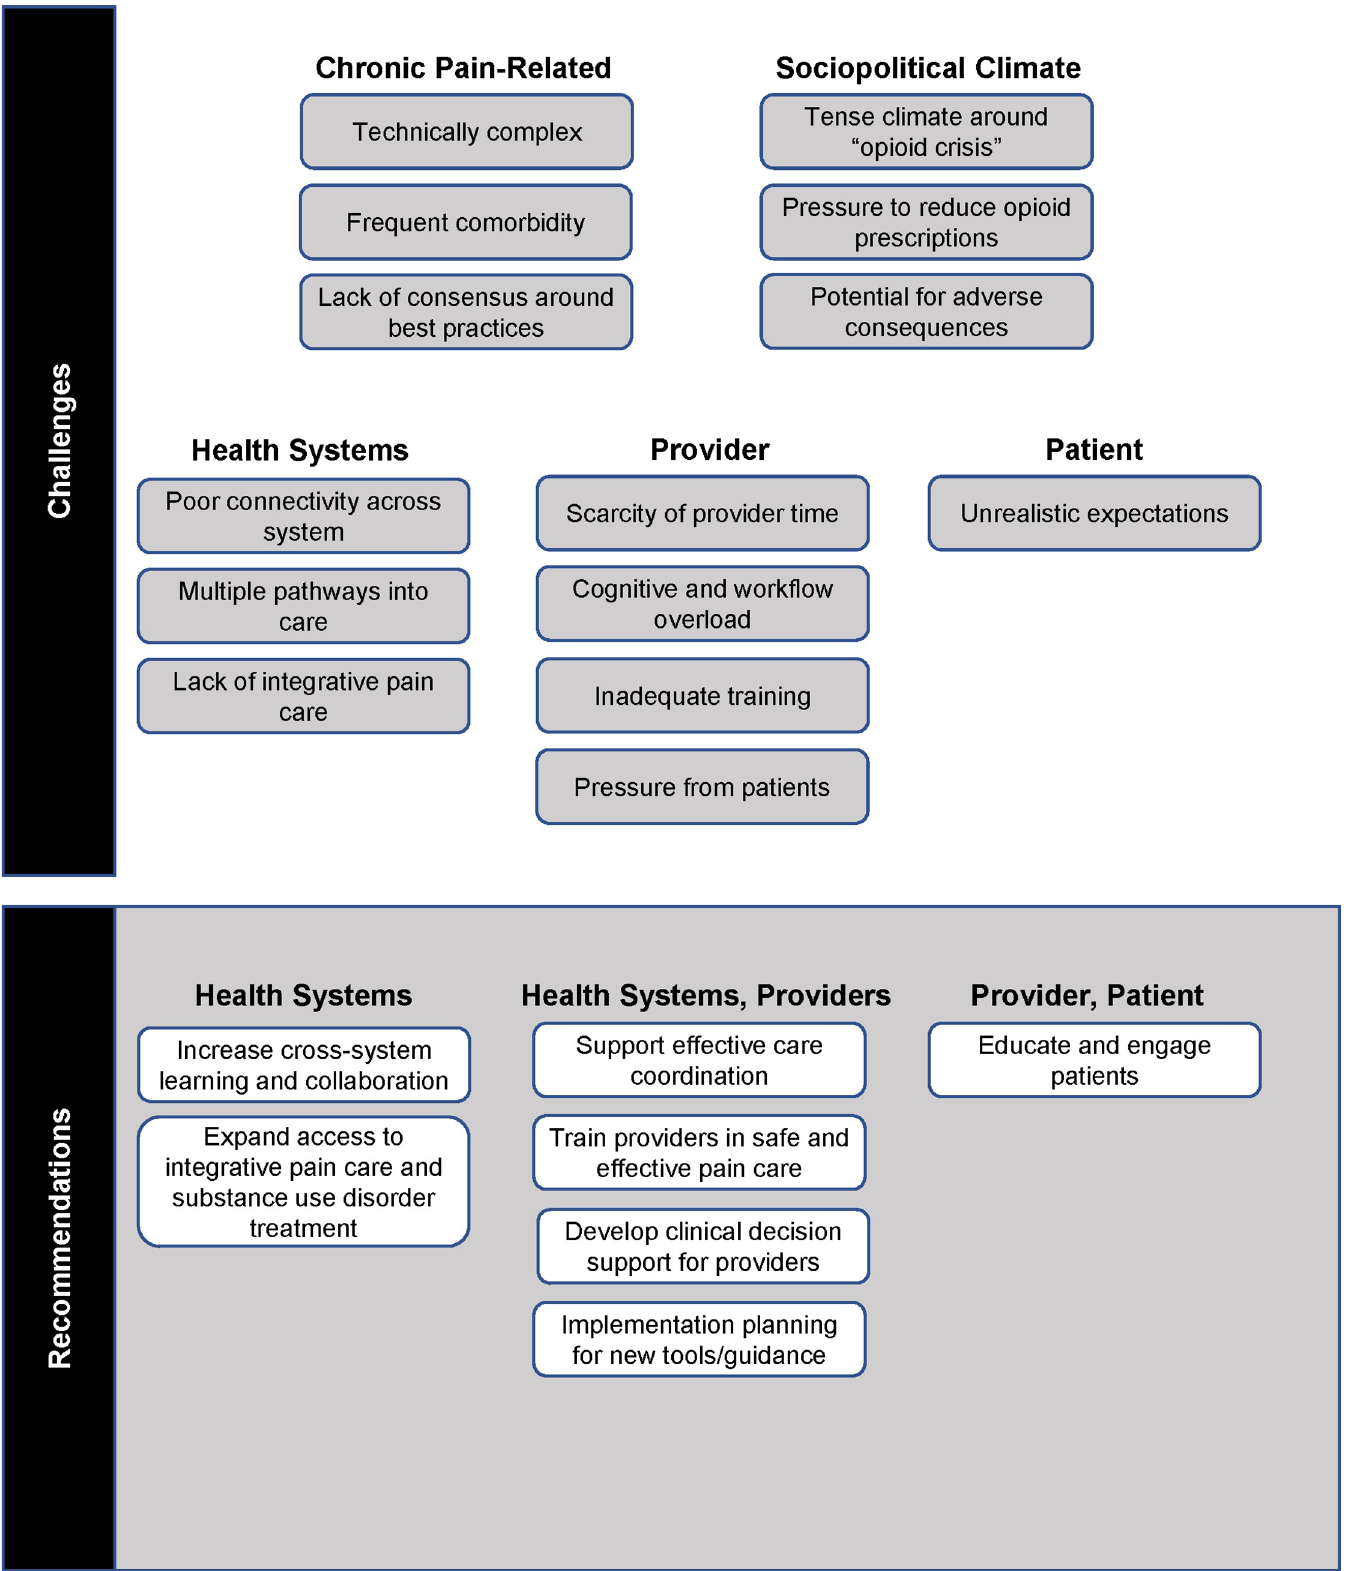
Fig 1. Core challenges and recommendations from national experts toward increasing the safety of opioid prescribing for chronic pain. https://doi.org/10.1371/journal.pone.0234425.g001 PLOS ONE | https://doi.org/10.1371/journal.pone.0234425 June 15,